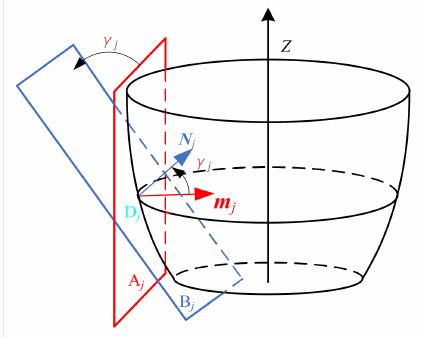
Figure 7. Rotation of the vertical